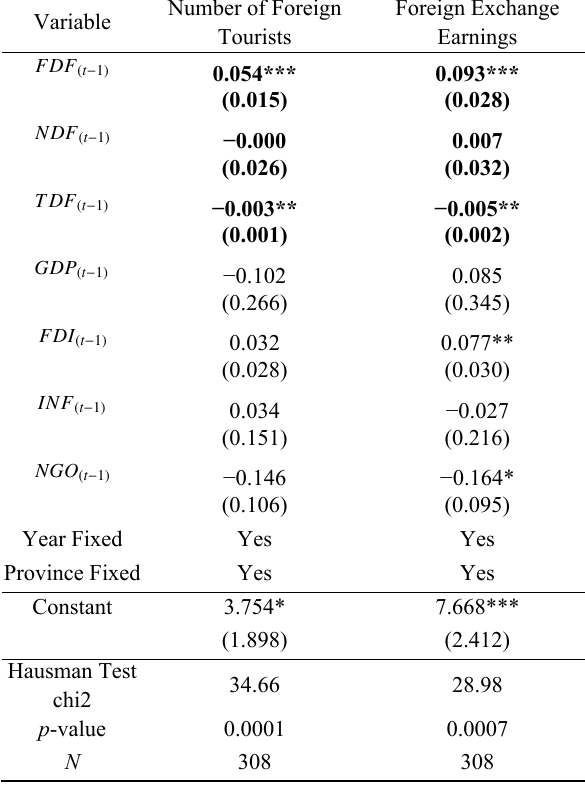
Table A2 Result by static panel model (fixed-effect for both year and